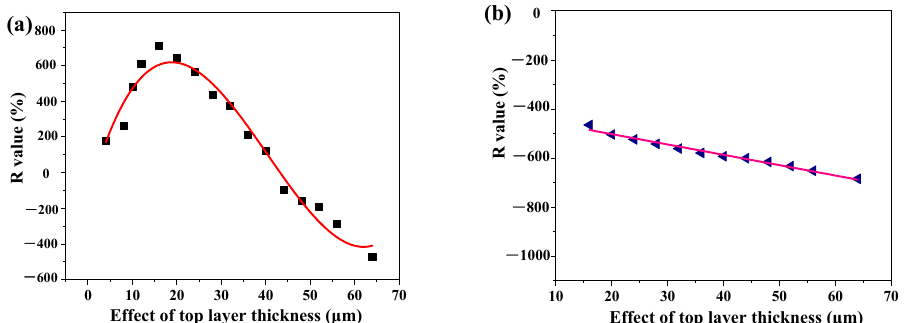
Figure 9. One-way transport index ( R value) of composite membranes with different hydrophobic layer thickness: ( a ) water was dropped onto the hydrophobic side, ( b ) water was dropped onto the hydrophilic side.